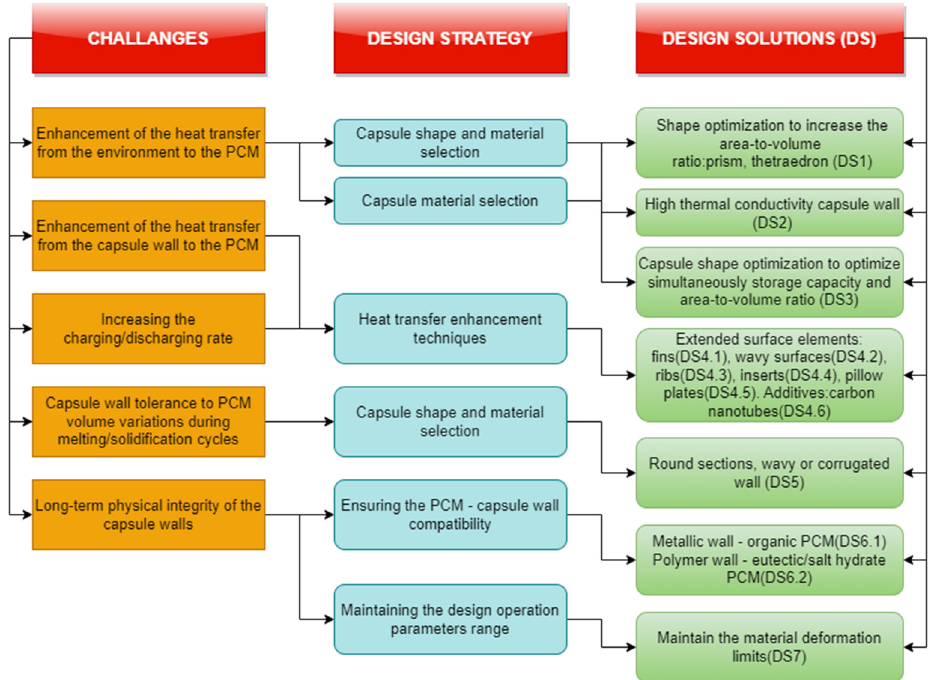
Figure 15. PCM macro-encapsulation design challenges and solutions.DS1: [129]; DS2: [126]; DS3: